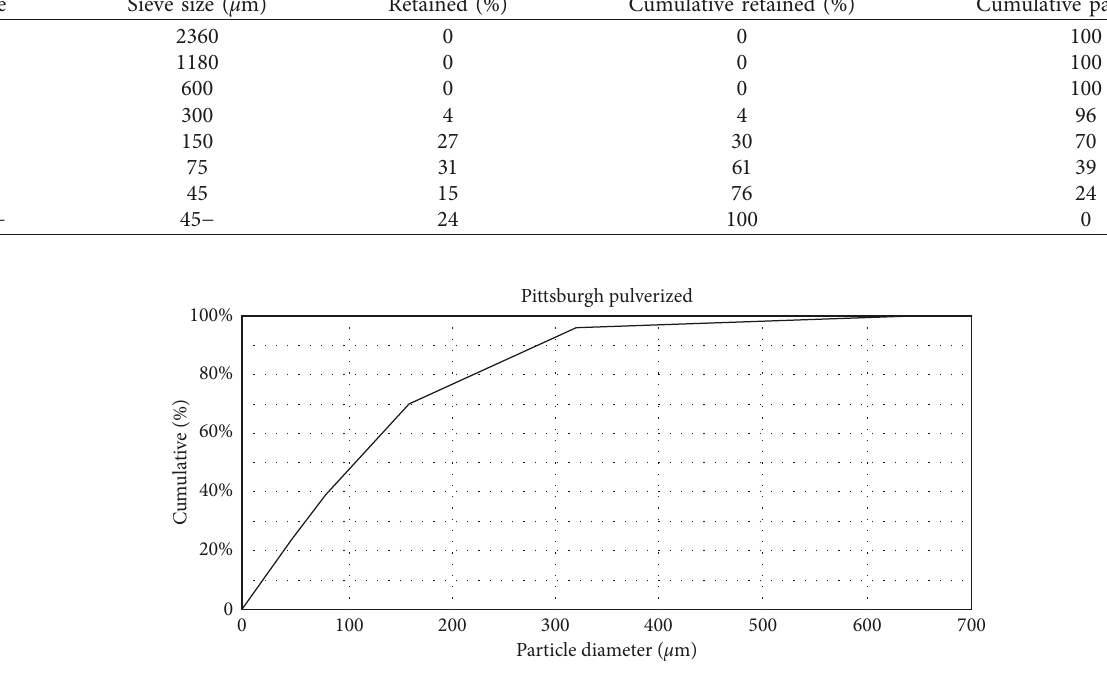
Figure 4: Particle size analysis for the Pittsburgh pulverized coal dust sample. Table 2: Proximate analysis of the Pittsburgh pulverized